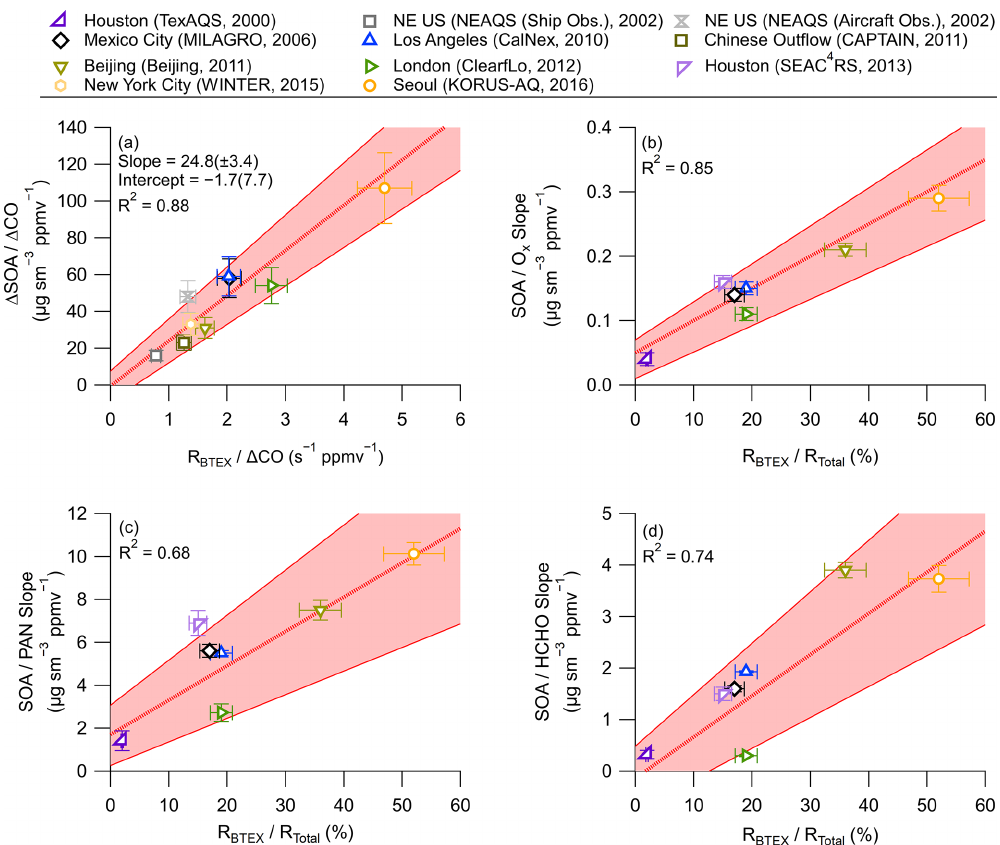
Figure 2. (a) Scatterplot of background and dilution-corrected ASOA concentrations ( (cid:49) SOA/ (cid:49) CO at PA = 0.5 equivalent days) versus ] i ) for multiple major field campaigns BTEX (benzene, toluene, ethylbenzene, and xylenes) emission reactivity ratio ( R BTEX = (cid:80) i [ VOC CO on three continents. Comparison of ASOA versus (b) O x , (c) PAN, and (d) HCHO slopes versus the ratio of the BTEX / total emission reactivity, where total is the OH reactivity for the emissions of BTEX + C 2 − 3 alkenes + C 2 − 6 alkanes (Tables S5–S7), for the campaigns studied here. For all figures, red shading is the ± 1 σ uncertainty of the slope, and the bars are ± 1 σ uncertainty of the data (see Sect.